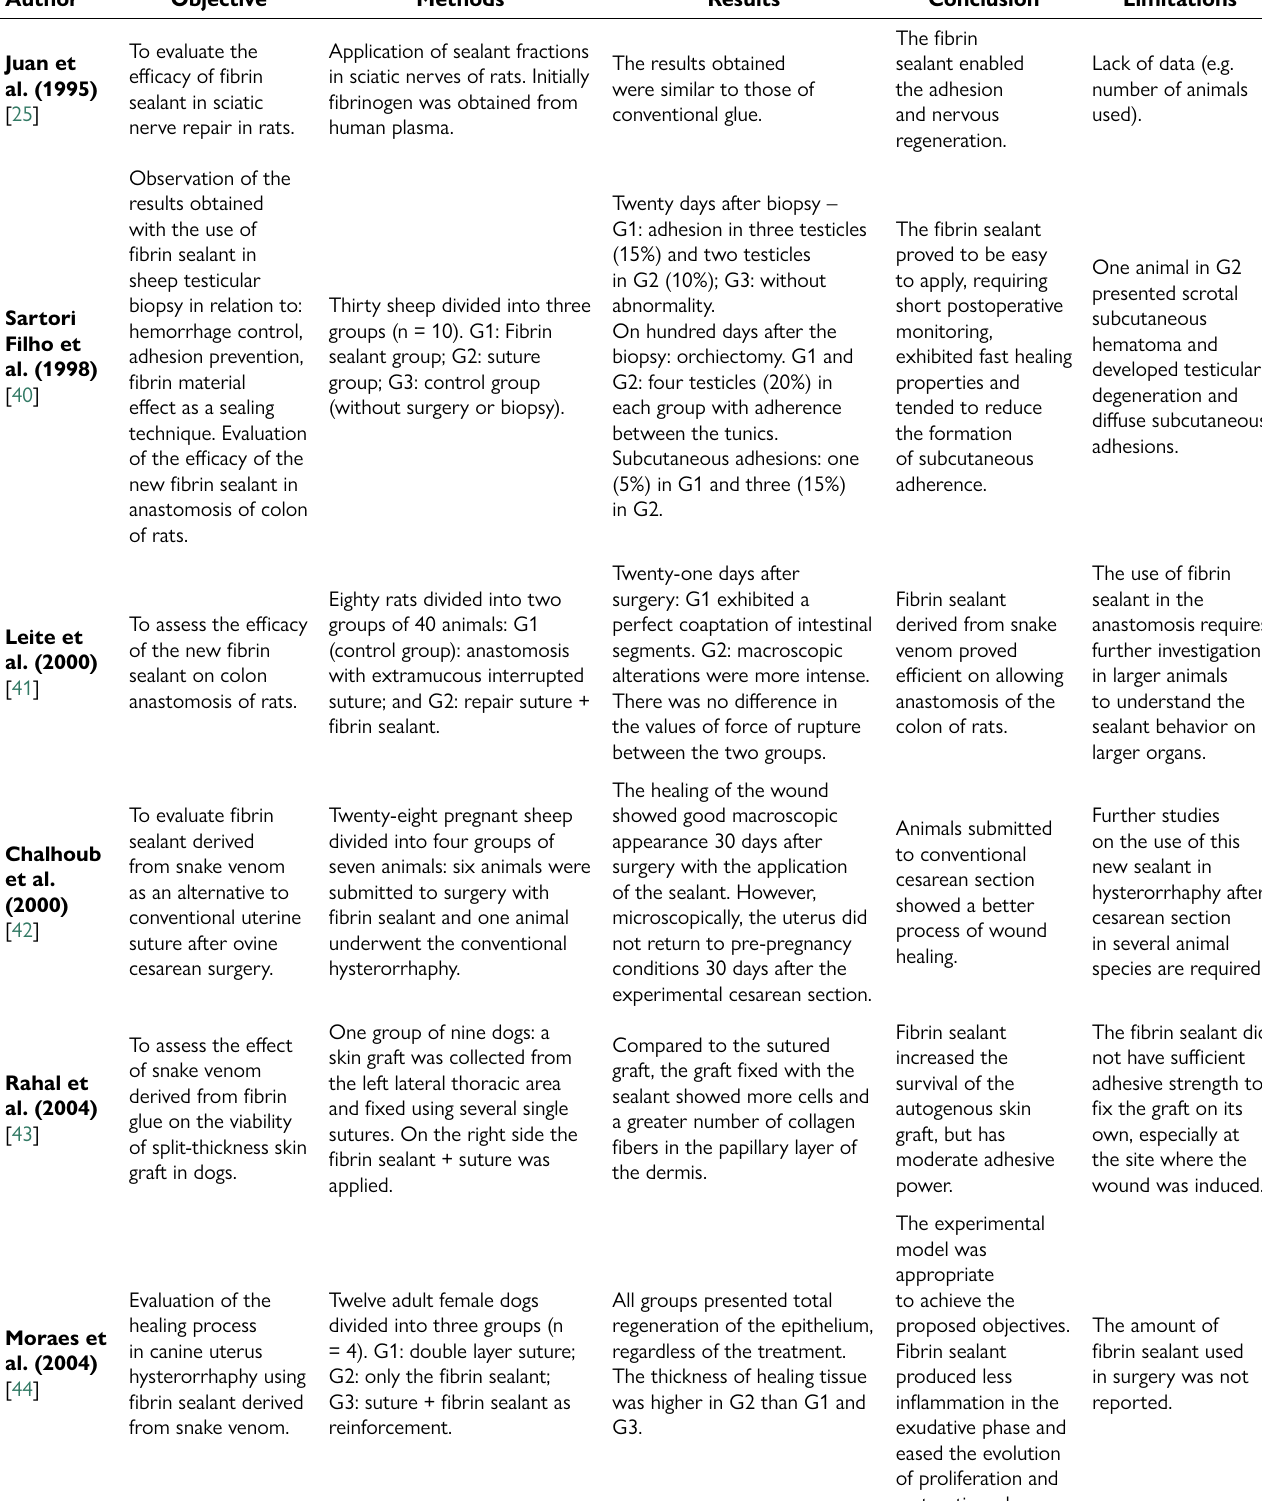
Table 1. Summary of articles included in this